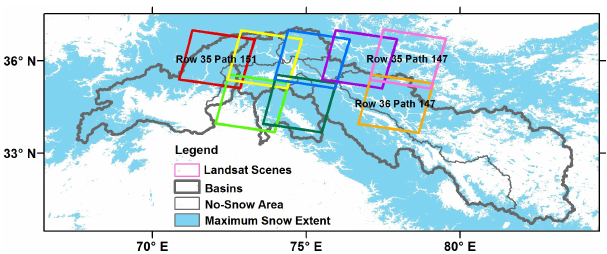
Figure 2. Landsat scenes used for validation of the MODIS Terra and Aqua products, covering most of the maximum snow cover ex- tent of the studied basins. Note: each colour indicates a unique lo- cation (“Path” and “Row”) of the Landsat scene